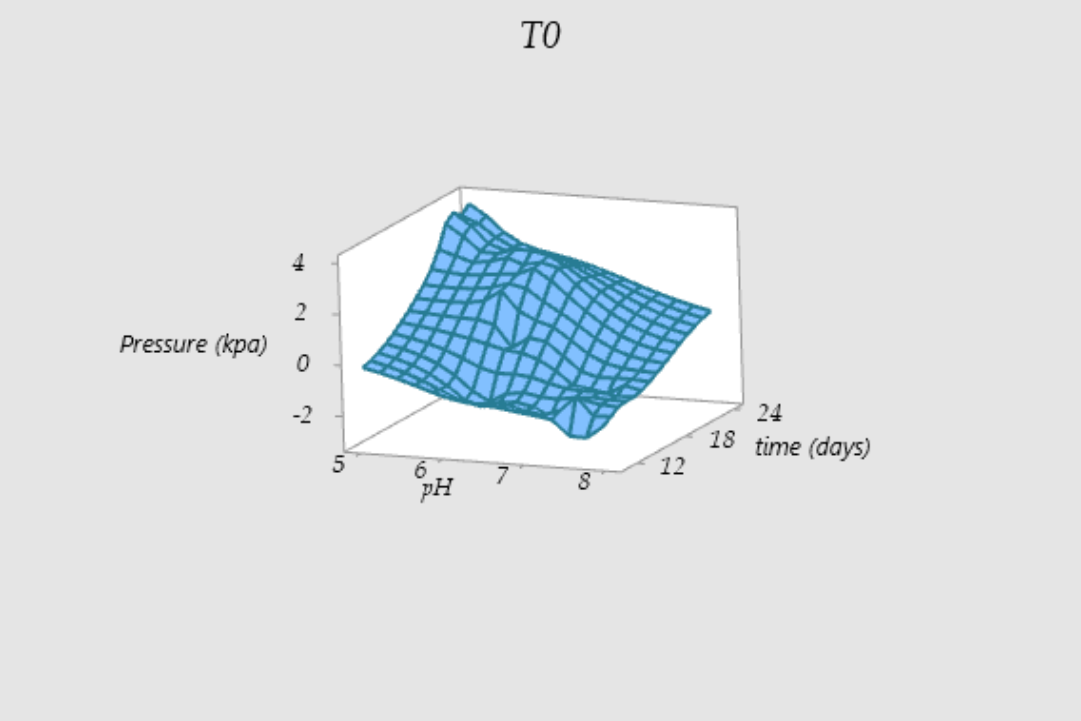
Figure 16. Behavior of pH and gas pressure over 25 days, in tank T0.